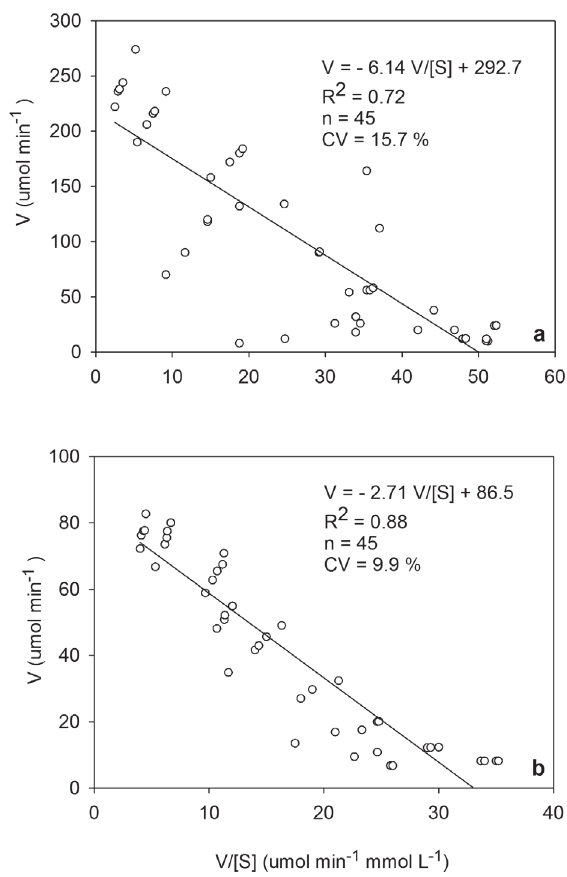
Figure 3 - Regression analysis of soil phosphatase activity using the Eadie-Hofstee model in the native Cerrado ( a ) and no-tillage ( b ). Where, values of determination coefficient (R 2 ), Coefficient of variation (CV %) and number of sampling (n) are shown. Parameters of equations of Eadie-Hofstee model are significantly fitted at a probability level of 1